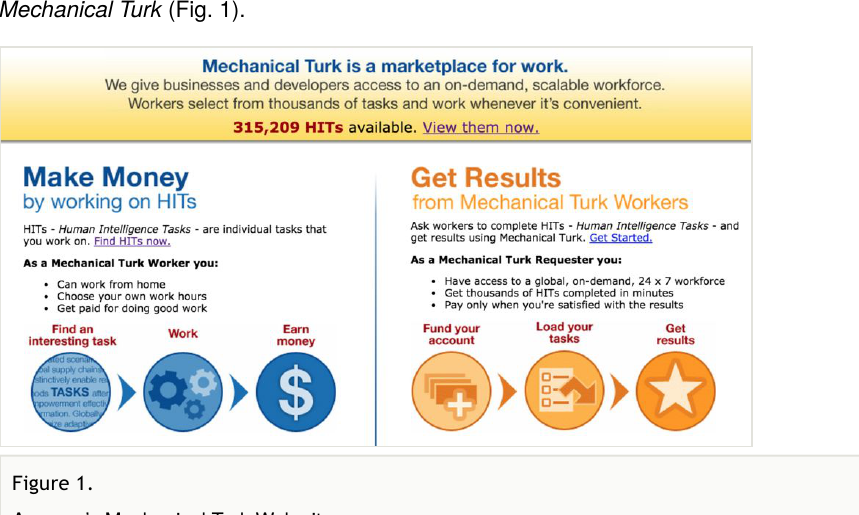
Amazon’s Mechanical Turk Web